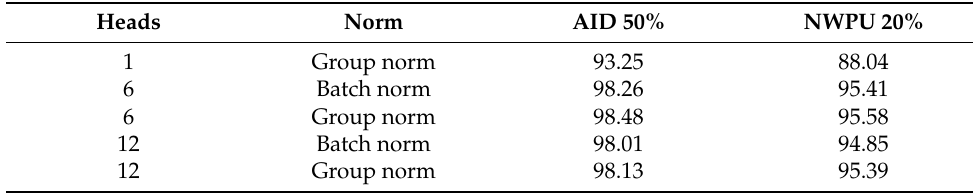
Table 13. Ablation study on MHSA-Bottleneck architecture. Heads